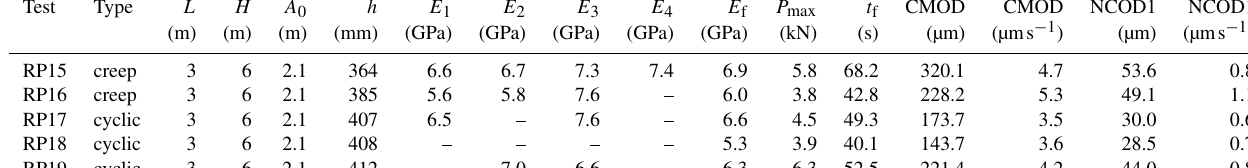
Table 1. Measured experimental data and computed results for the LC tests. Test